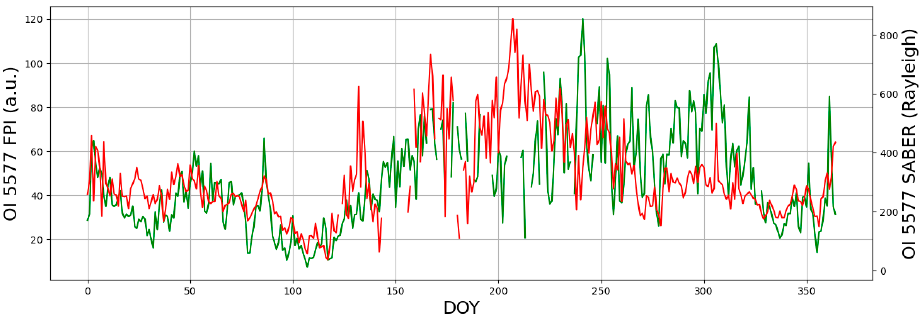
Figure 1. Annual average I 557.7 nm from 2017 to 2021 since January 1 from SABER (red) and FPI data (green).